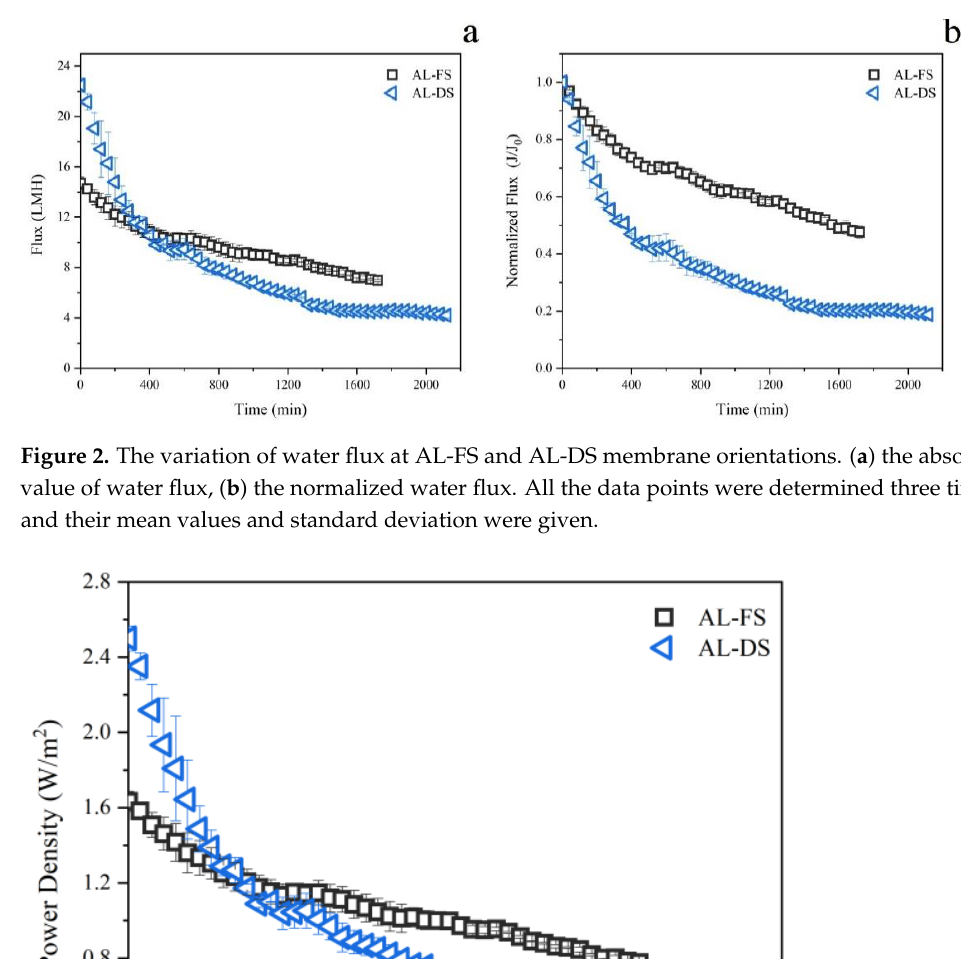
Figure 3. The variation of power density at both AL-FS and AL-DS membrane orientations.